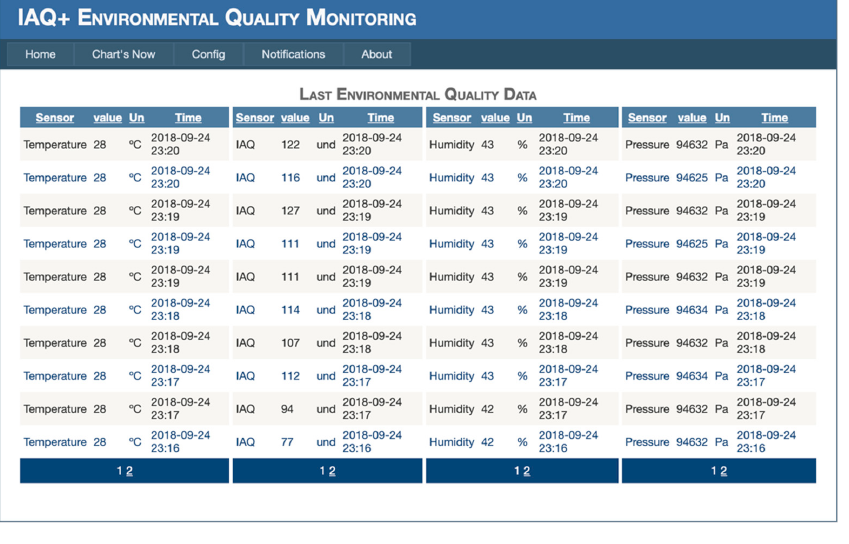
8 of 17 Figure 3. iAQ+Mobile